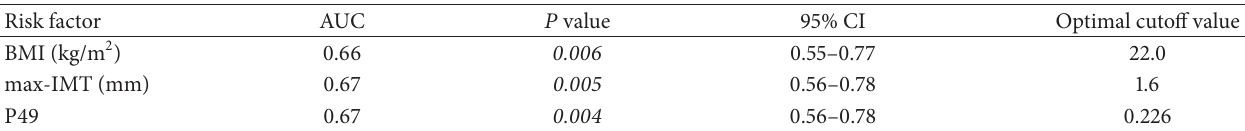
Table 4: Receiver operating characteristic (ROC) curves for independent prognostic factors to determine the area under the curves (AUCs) and the optimal cutoff values.